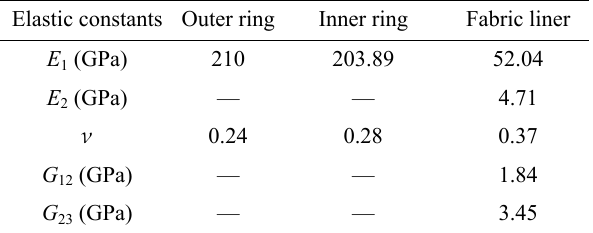
Table 3 The mechanical properties of self-lubricating spherical plain bearing.